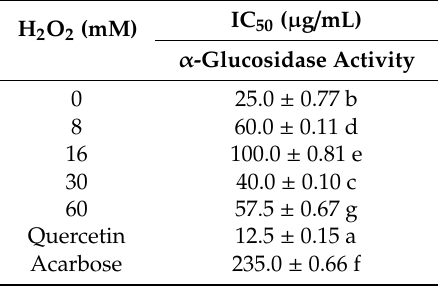
37.51 mg of GAE /